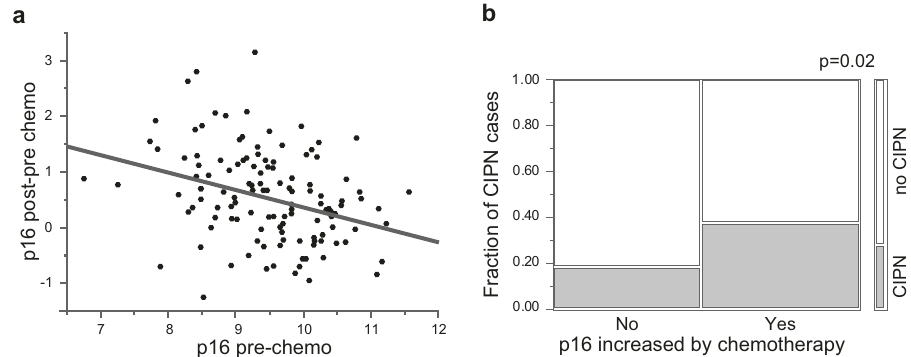
Fig. 3 Chemotherapy-induced increase in p16 as risk factor for CIPN. Participants with low p16 were more likely to experience a chemotherapy-induced increase in p16 and were more likely to develop taxane-induced CIPN. a Correlation between p16 expression prior to chemotherapy and chemotherapy-induced change in p16 expression measured at the end of chemotherapy regimen. b Mosaic plot of incidence of CIPN. CIPN group is shown in gray, no CIPN in